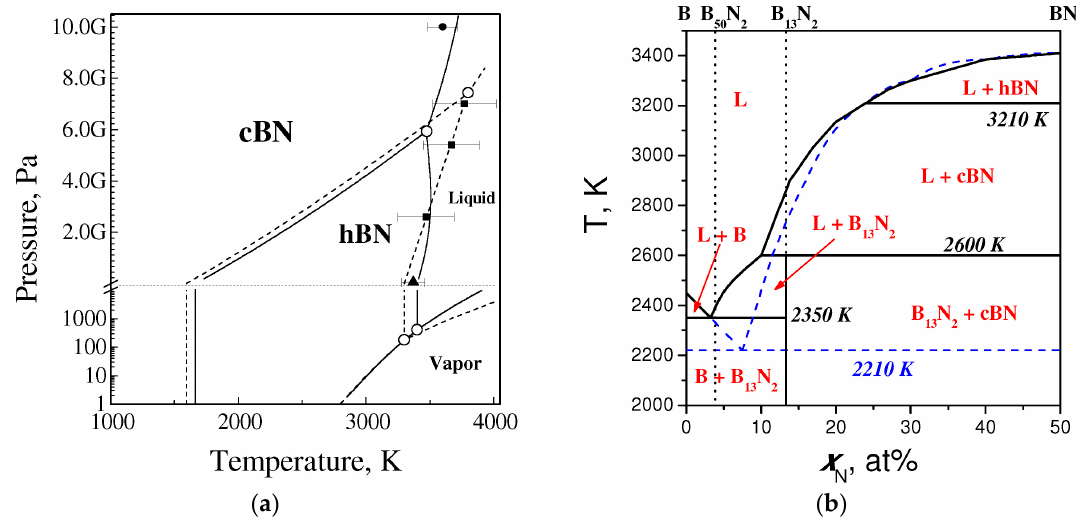
Figure 7. ( a ) Equilibrium phase P , T -diagram of boron nitride (solid lines—the refined diagram [69], dashed lines—diagram of 1988 [68]). Solid squares show Wentorf's data on hBN melting [66], solid circle is the melting point of cBN at 10 GPa [76], and solid triangle is hBN melting point at 50 MPa [74]; ( b ) Phase diagram of the B–BN system at 5 GPa [62]. Solid and dashed lines show the equilibrium and metastable phase diagrams respectively.